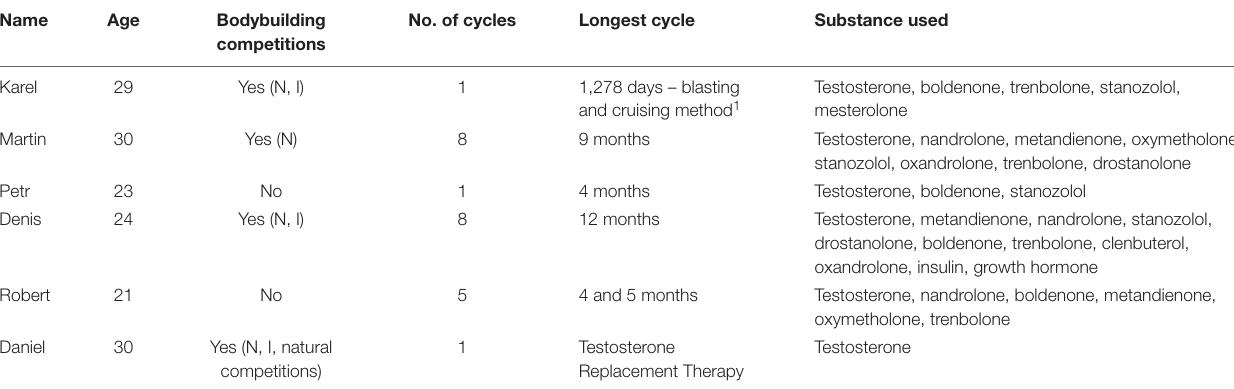
TABLE 1 | Characteristics of the